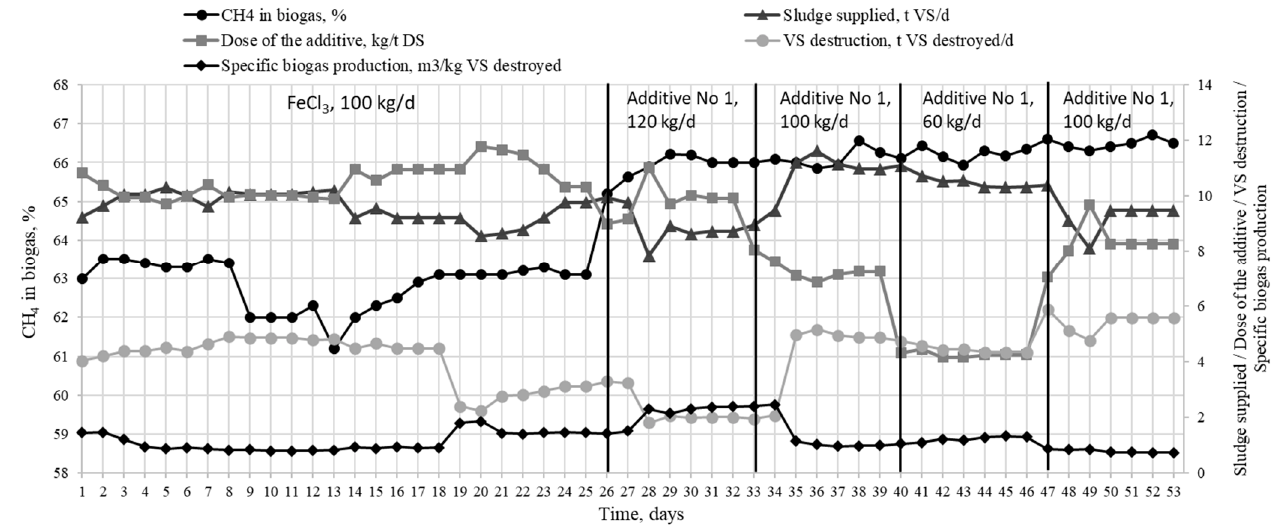
Figure 8. Results of full-scale test.